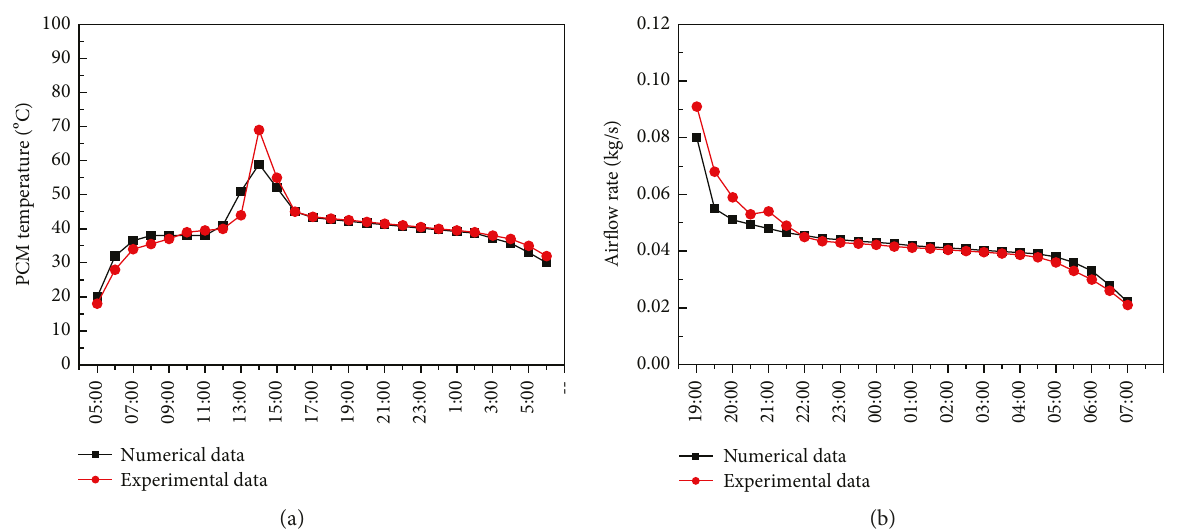
Figure 10: The schematic diagram of the experimental solar